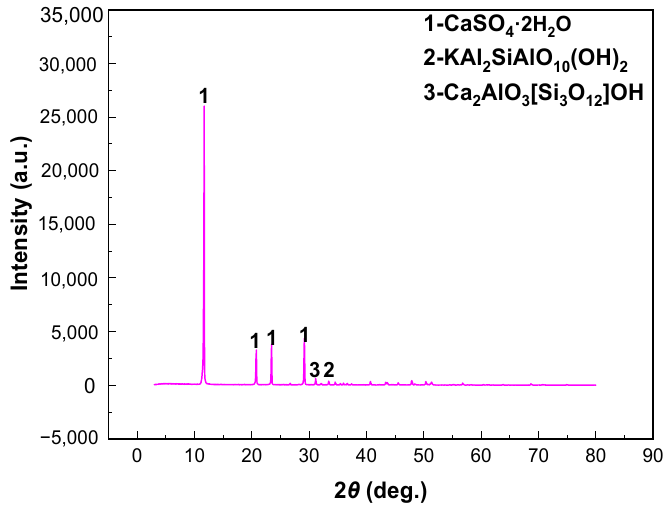
Figure 9. XRD patterns of gypsum concentrates.